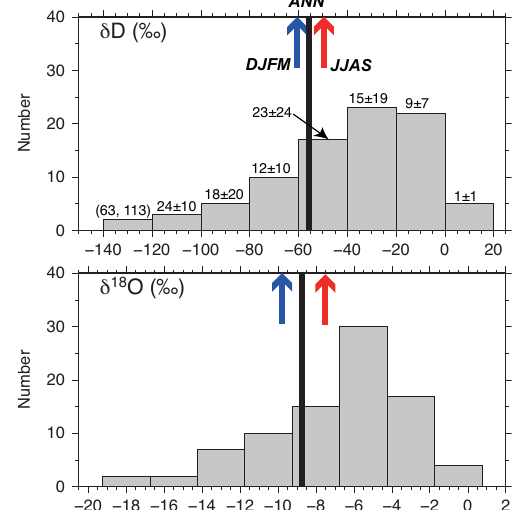
Figure 4. Histograms of (upper panel) δ D and (lower panel) δ 18 O values in event-based precipitation. The black line represents the annual mean value weighted by precipitation amount. Blue and red arrows correspond to the winter (DJFM) and summer (JJAS) mean value. The numbers on each bar in the top figure represent average precipitation amount at each